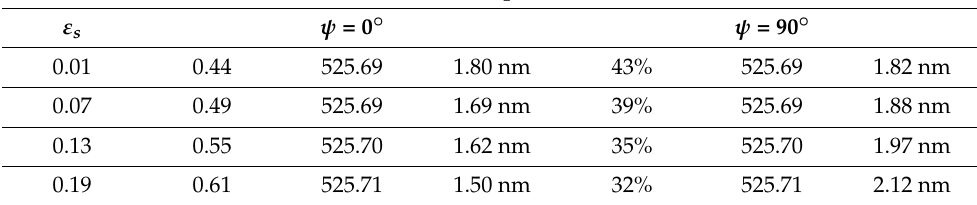
Table 3. Comparison of the suggested sensor performance with the results of the previous sensors.